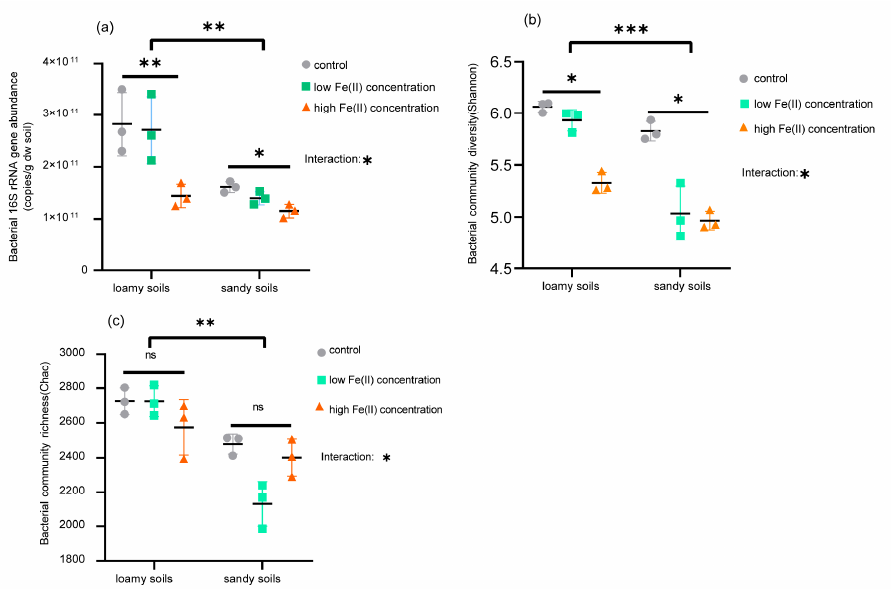
Figure 1. The bacterial abundance and diversity in different soil treatments; 16S rRNA gene copy numbers derived from qPCR ( a ) and indices of alpha diversity shown as Shannon ( b ) and Chao ( c ). Significant differences between Fe(II) concentrations and soil textures were determined by two-way ANOVA marked by different capital letters. The symbols *, **, and *** are used to show statistical significance at the 0.05, 0.01, and 0.001 level, respectively. ns represents no statistical significance at the p = 0.05 level.